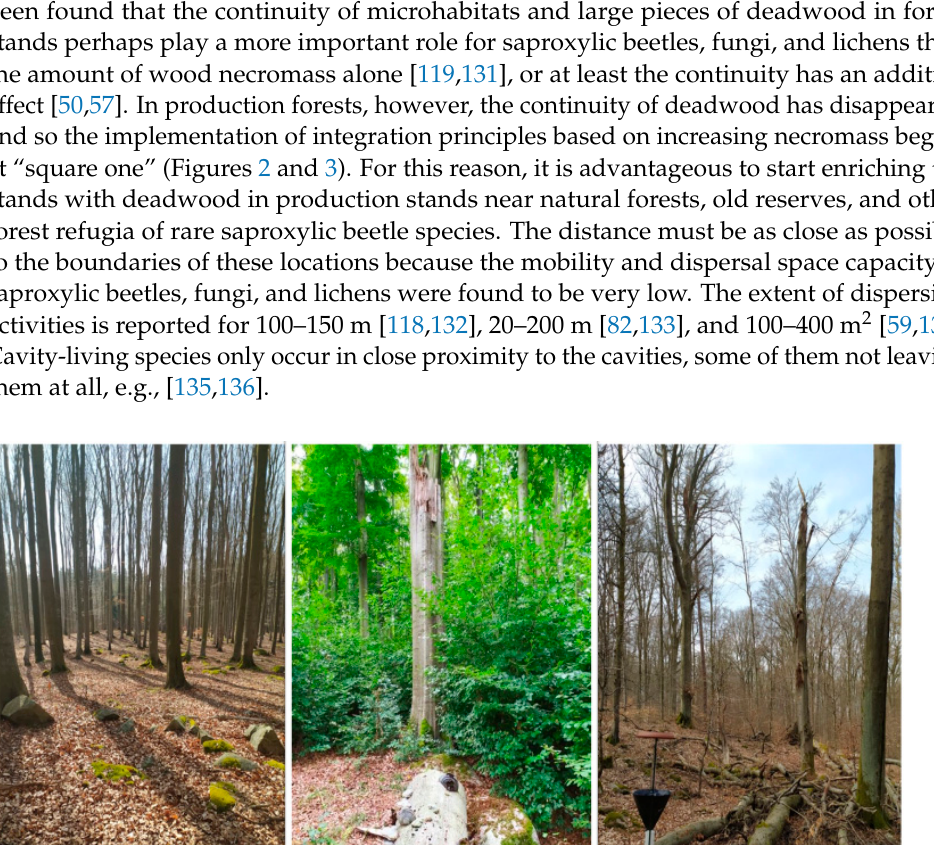
Figure 3. Stages of enrichment: ( 0 ) A stand with no deadwood. ( a The first leaving of the wood to disintegrate. ( b ) A medium-intensity decomposition degree at about 2/3 of the time period of the enrichment. ( c ) A barely visible, highly decomposed log and the following phase of the purposeful leaving of the deadwood in the site. The arrow above the picture indicates the decomposition pro- cess, the lighter the shade, the more decomposed the wood. Table 2. Volume of deadwood in the forest reserve. Volume (m 3 /ha)